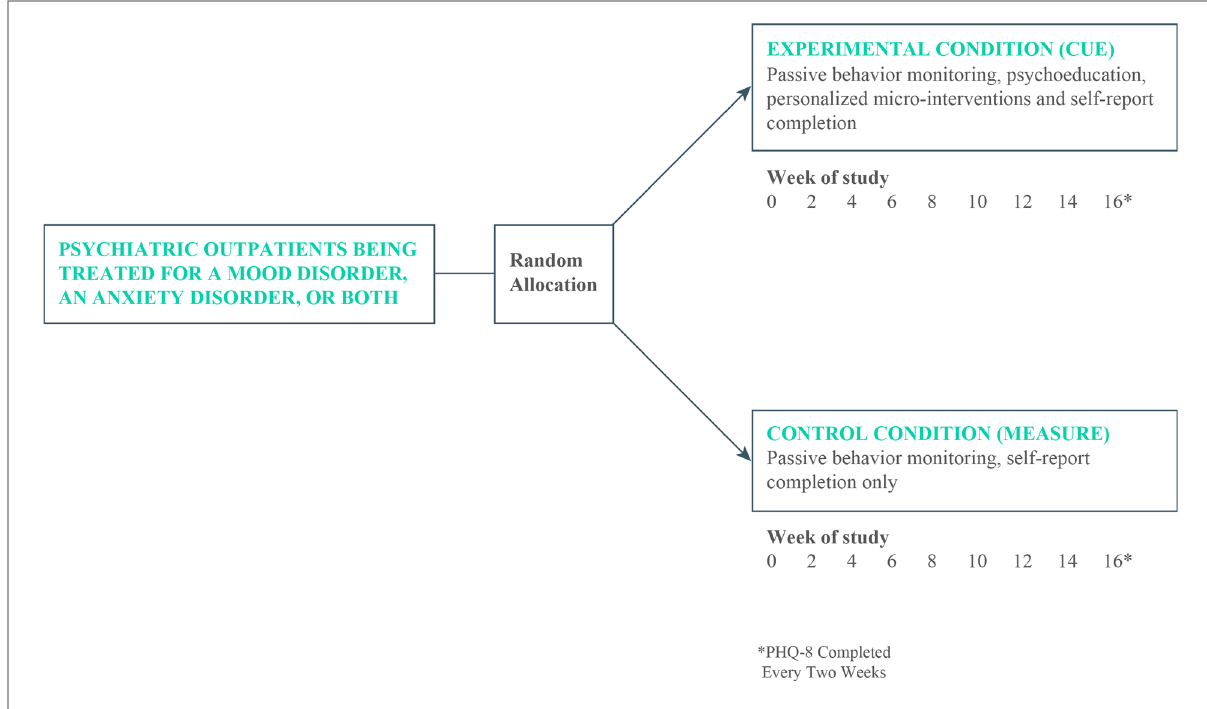
FIGURE 1 Design of RCT comparing a digital intervention platform with monitoring only.